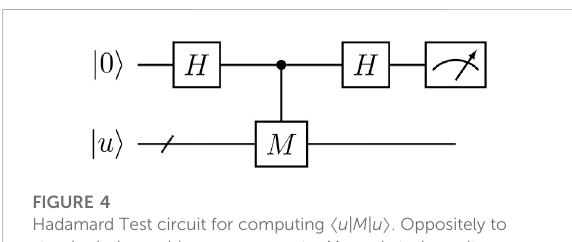
FIGURE 4 Hadamard Test circuit for computing 〈 u | M | u 〉 . Oppositely to standard observable measurements, M needs to be